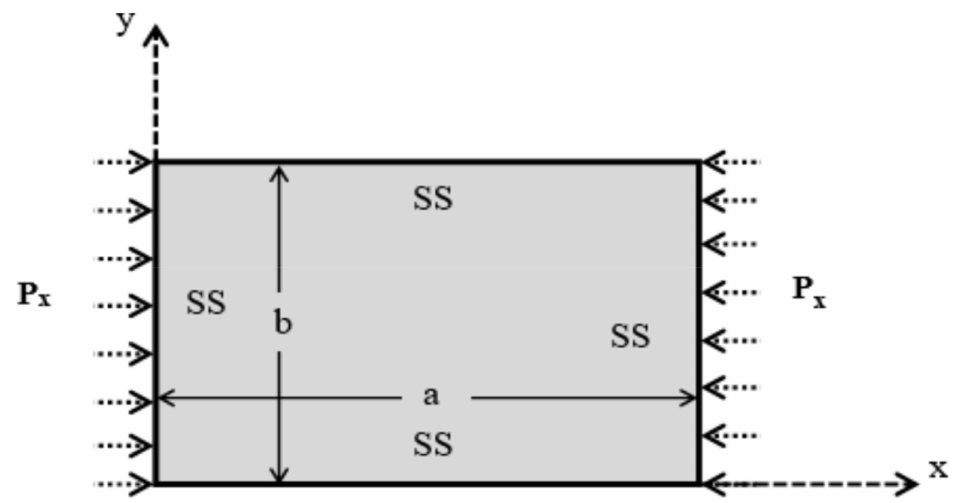
Figure 3. Boundary conditions of the FGM plate represented in [30].